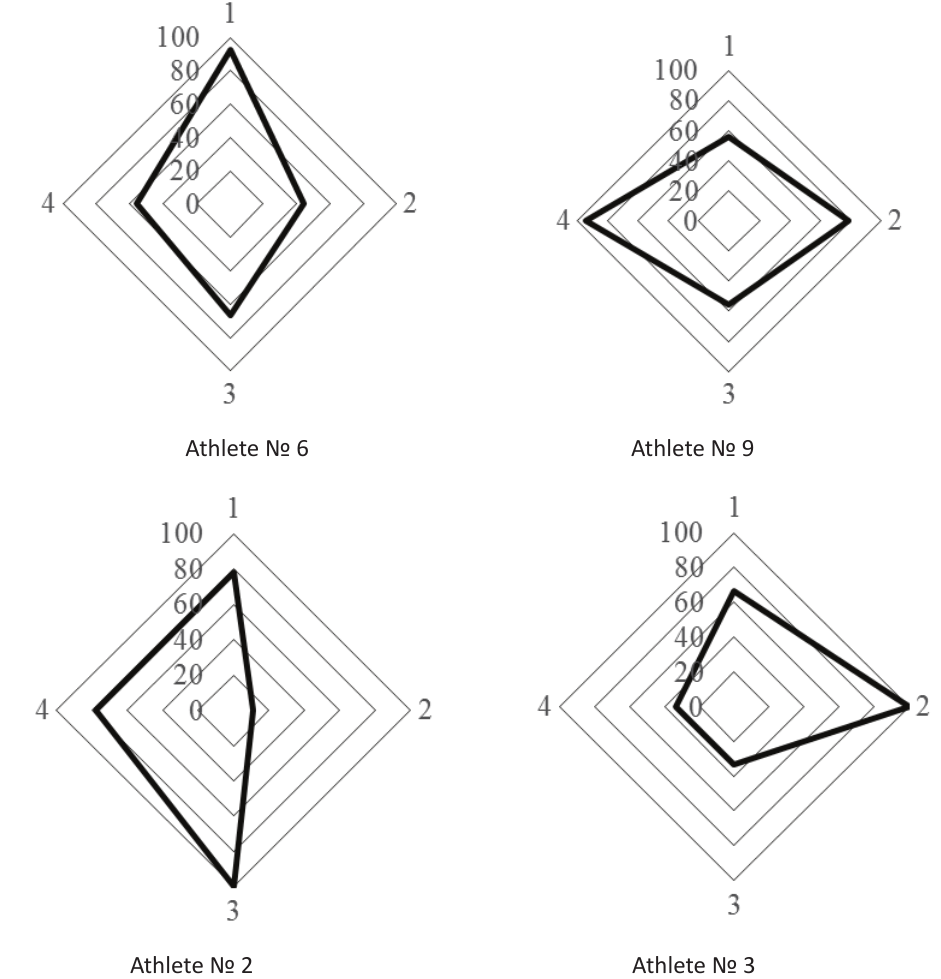
Fig. 2. Personal factorial structure of the functional and psychophysiological capabilities at athletes: 1 - Factor of “Sympathicotonia”; 2 - Factor “Strength”; 3 - Factor “Speed”; 4 - Factor of